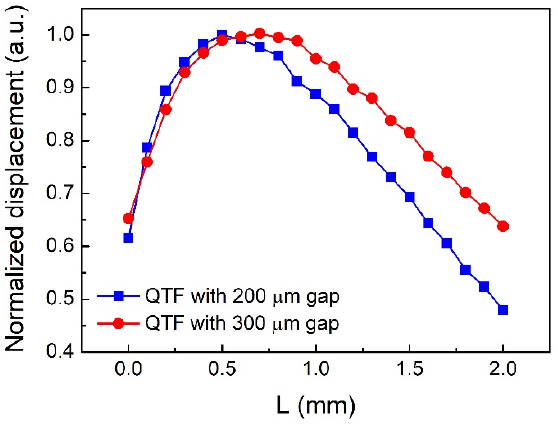
Figure 4. Normalized calculated displacement as a function of vertical height (L) for two different QTFs.